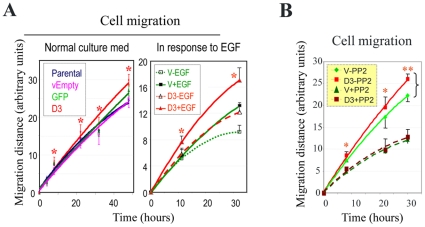
Effect of Dsg3 overexpression on cell migration.(A) Under both normal culture conditions and in the presence of EGF (100 ng/ml) the hDsg3.myc cells were more migratory (p<0.05) than their control counterparts. (B) This increased migratory ability was abrogated almost totally by treating cells with PP2 (10 µM), a Src-specific inhibitor.